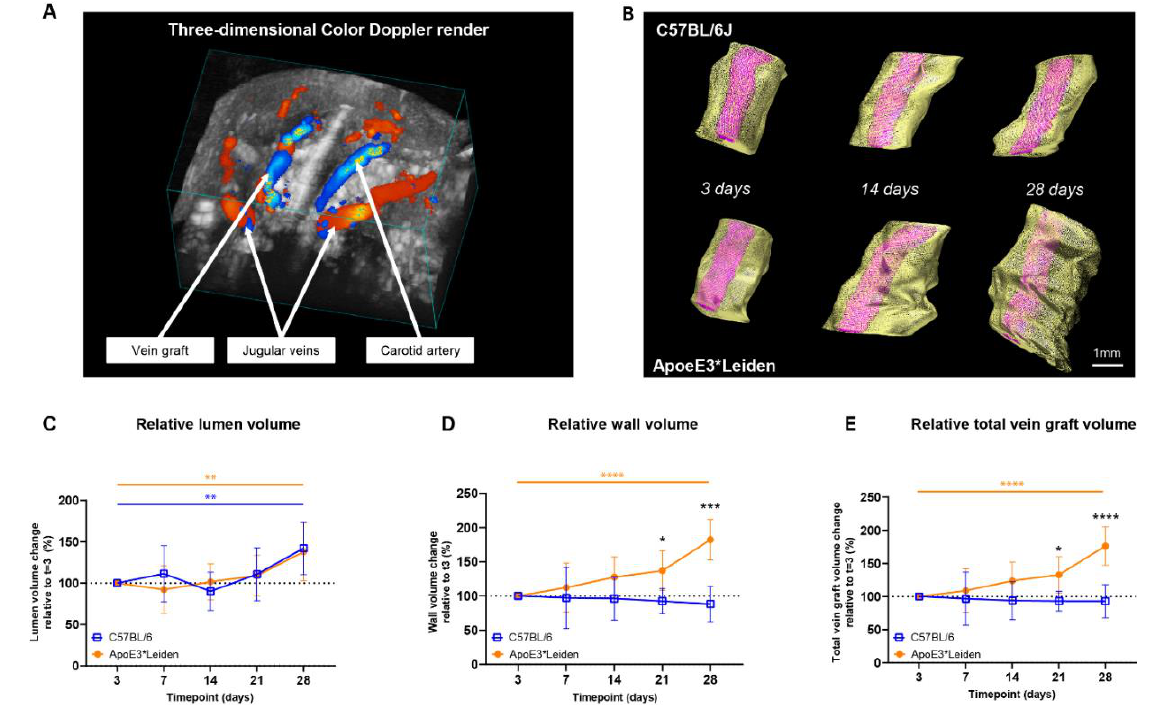
Figure 2. Volume measurements in the vein grafts of C57BL/6J and ApoE3*Leiden mice over time. ( A ) A three-dimensional color Doppler maximal intensity projection of the neck region of a vein grafted mouse. The nearest panel of the cube depicts the caudal side. ( B ) Representative vein graft three-dimensional renders of C57BL/6J mice and ApoE3*Leiden mice, depicting vascular remodeling over time. ( C – E ) Graphical representations of, respectively, lumen volume ( C ), wall volume ( D ), and total vein graft volume ( E ) of C57BL/6J ( n = 7, chow diet) and ApoE3*Leiden mice ( n = 7, high-fat diet), calculated relative to their baseline measurements at t = 3 days post-surgery. Total vein graft volume is a measure for outward remodeling. Volume calculations were corrected through a volume-per-length approach. Statistics: ANOVA mixed model, corrected for multiple testing; * p < 0.05, ** p < 0.01, *** p < 0.001, **** p < 0.0001.